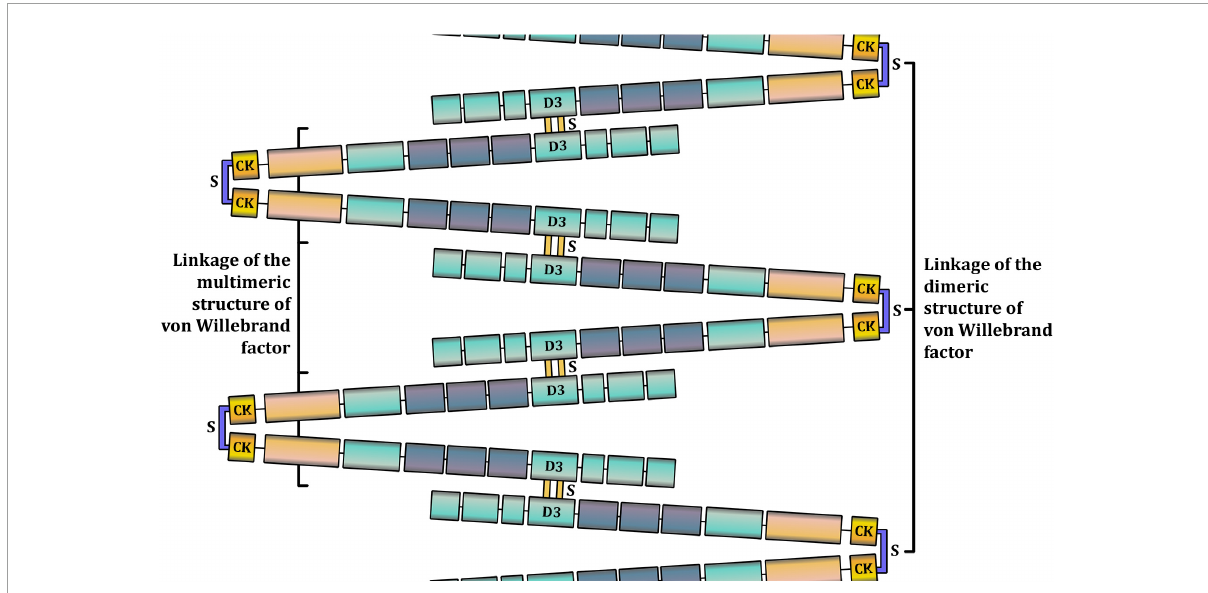
FIGURE2 A schematic representation of the multimeric structure of Von Willebrand factor (VWF). In the bloodstream, VWF is present in a range of multimers, from dimers (around 500 kDa) to high-molecular weight multimers (10,000 kDa and more). The larger the VWF multimer is, the more hemostatically active it is. VWF monomers are dimerized in the C-terminal cysteine knot (CTCK) through disulfide bonds. Other disulfide bonds bind VWF dimers in D domains to form multimers.